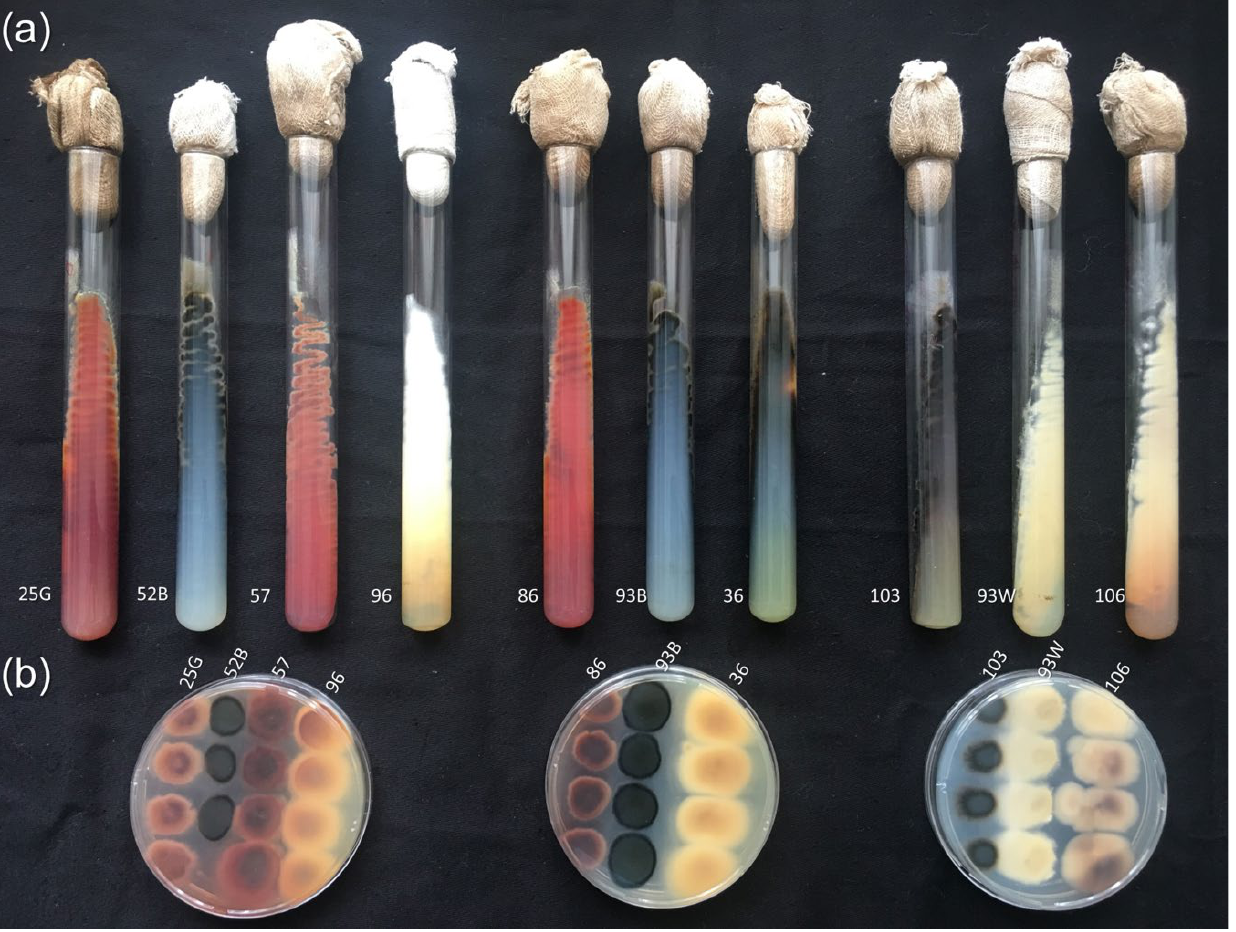
Figure 1. Cultivation of fungi-destructors of tempera paintings, isolated in the State Tretyakov Gallery (STG, Moscow, Russia) on Czapek-Dox agar (CDA) medium, 25 °C, 15 days. ( a ) Slant CDA medium; ( b ) CDA medium on Petri dishes. Fungal strains, from left to right: STG-25G, STG-52B, STG-57, STG-96, STG-86, STG-93B, STG-36, STG-103, STG-93W, STG-106.